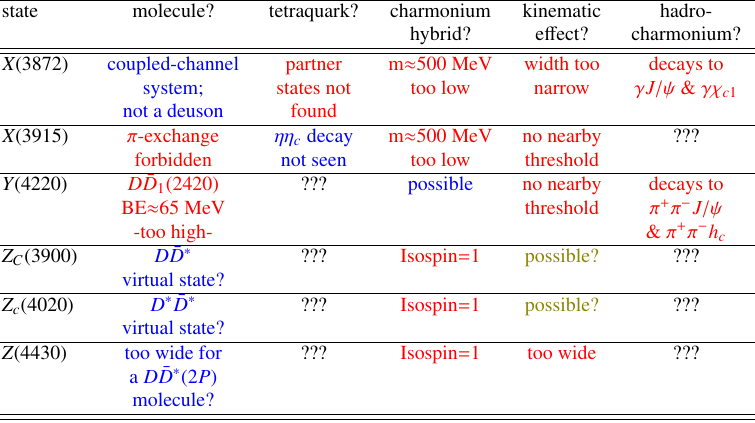
Table 1. Comparison of meson properties with model expectations. The text describes the color code.